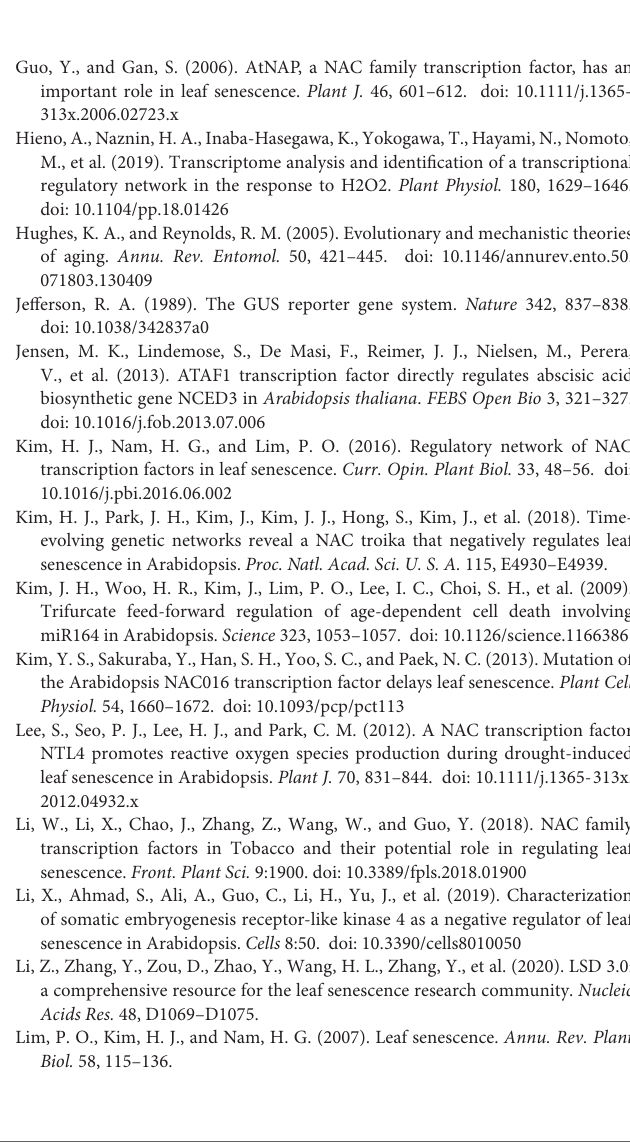
Supplementary Figure 1 | Transcript level of SAG12 , AtNAP and ORE1 increases as leaf ages. Supplementary Figure 2 | PCR genotyping of the nac075 mutants. Supplementary Figure 3 | Overexpression of NAC075 delayed leaf senescence. Supplementary Figure 4 | The age-dependent pods senescence phenotype of 30-d-old Col-0 and nac075 mutants. Supplementary Figure 5 | Senescence phenotypes of Col-0, nac075 mutants and NAC075ox plants. Supplementary Table 1 | Primers used in this study. Supplementary Dataset 1 | The differential expressed genes in nac075